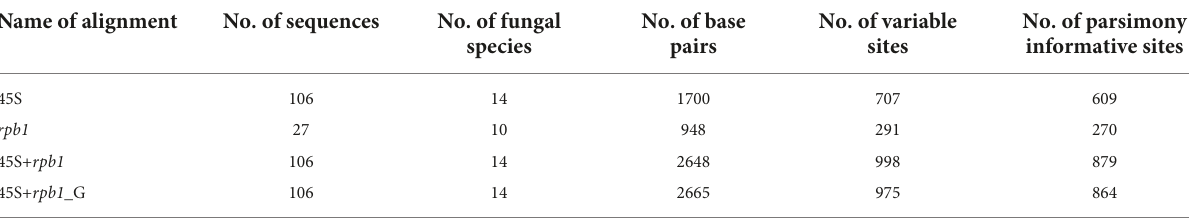
TABLE 1 Characteristics of the sequence alignments